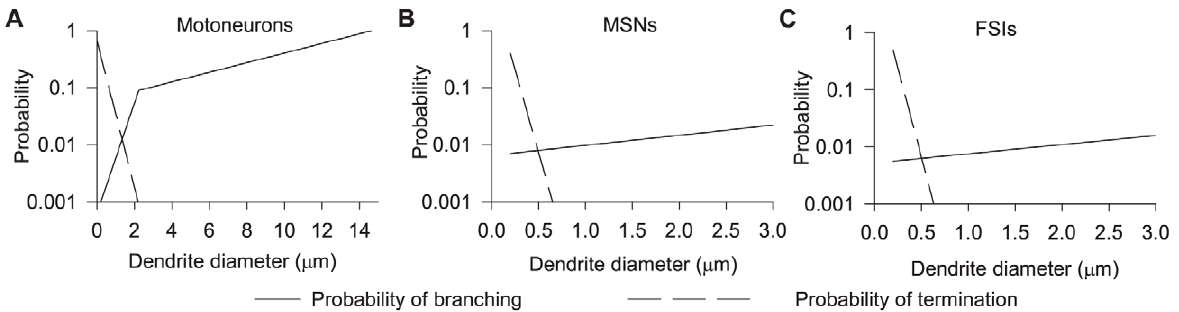
Figure 3. Probability of a branch or termination event as a function of the diameter of the dendrite. The dashed line plots the probability function for termination; the solid line plots the probability function for branching, given by equation (2). A The original functions from [52]. Branching probability is given by two exponential functions. B Probability functions found for the MSN dendrite models. C Probability functions found for the FSI dendrite models. The searches for both MSN and FSI dendrite models suggest that only a single exponential function is needed to describe the branching probability in these neurons.